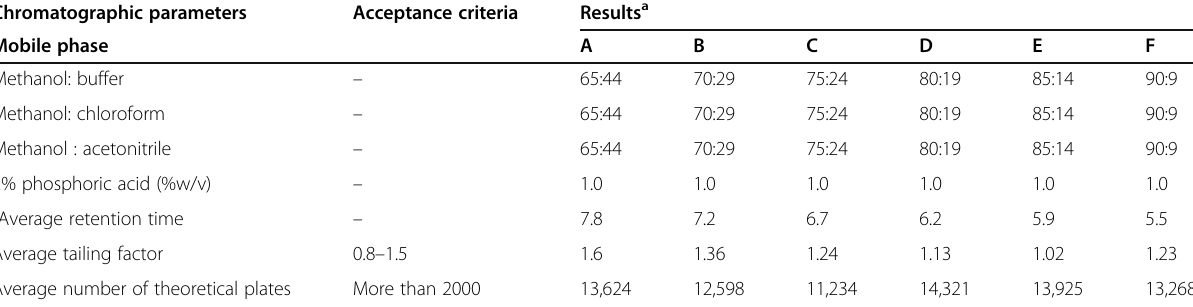
Table 1 Mobile phase optimization using different solvents and their mixtures Chromatographic parameters Acceptance criteria Results a Mobile